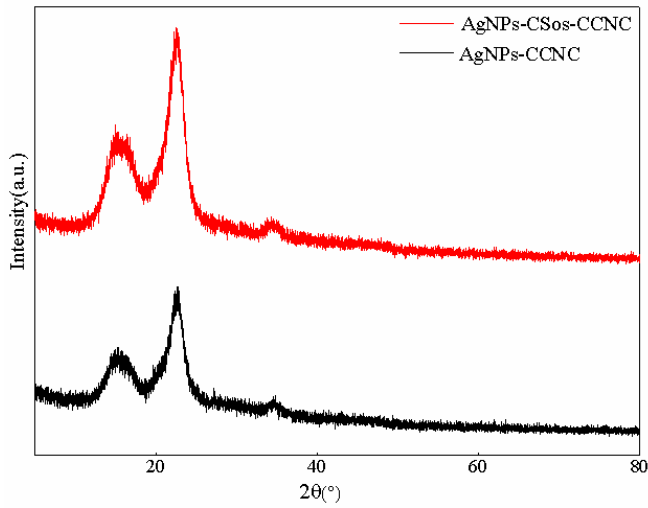
Figure 5. XRD curves of AgNPs-CCNC and